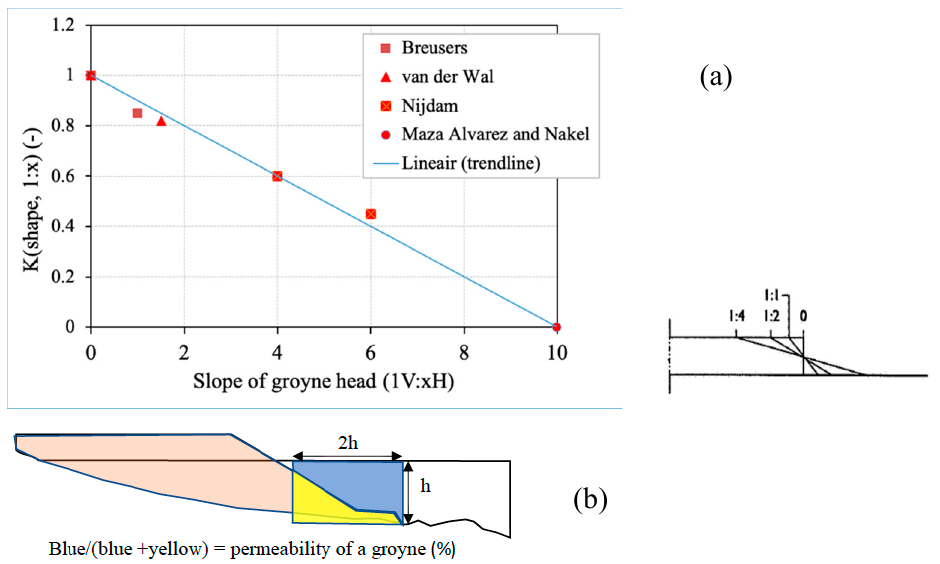
Figure 17. ( a ) K shape, 1:x as an approximate function of the slope of a groyne head 1V:xH and the length of a groyne meets 0.1 < B / B m < 0.3 (prepared by author). ( b ) Definition sketch of a groyne with the same groyne length and di ff erent slopes of the groyne head and the definition sketch of groyne permeability (prepared by author).